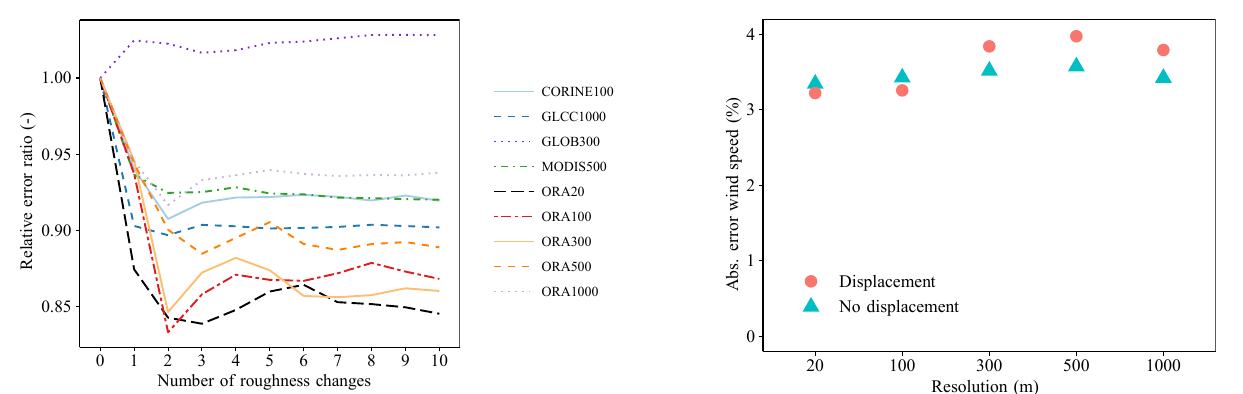
Figure 9. The mean absolute error of the simulations with the ORA maps with and without applying a displacement height for different map